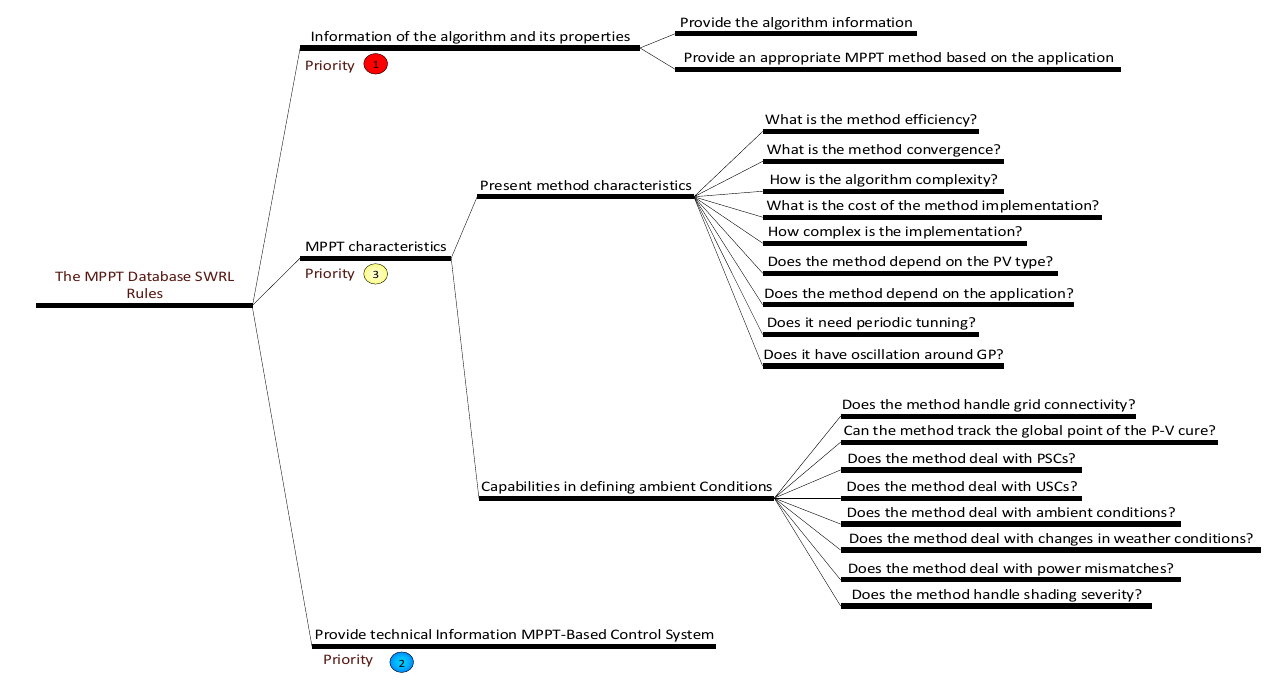
Figure 6. The structure of SWRL rules used for the MPPT database. Table 2. The effects of airborne particles affecting PV